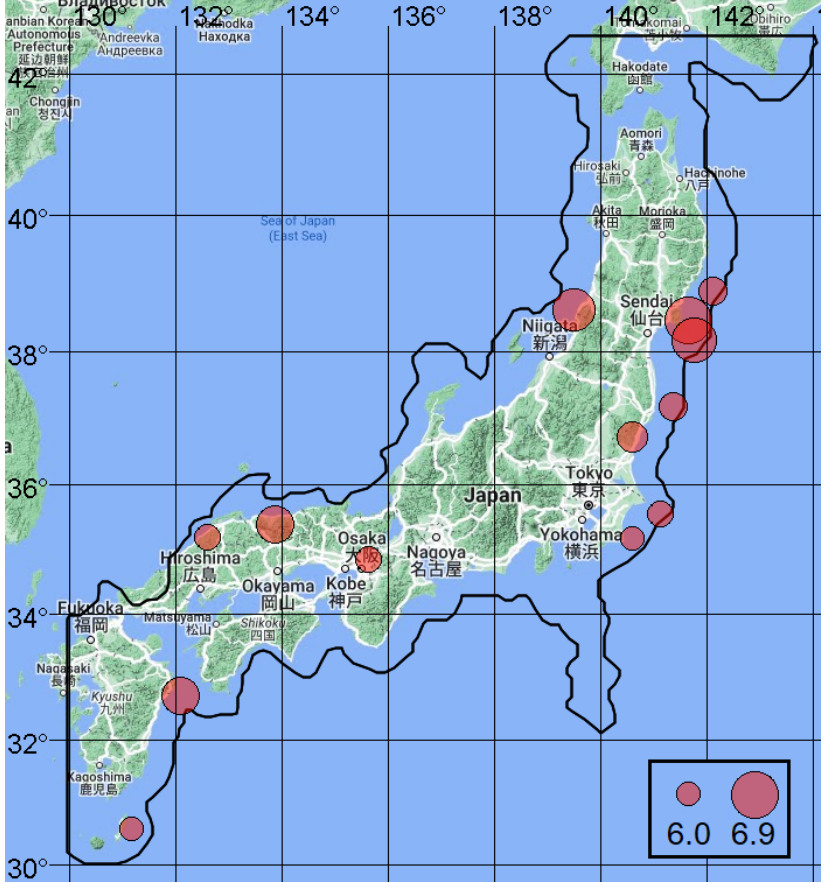
Figure 11. Japan region: analysis zone and epicenters of test earthquakes in the interval 3 August 2016–29 January 2023 with magnitudes with magnitudes m ≥ 6.0 and hypocenter depths H ≤ 60 km. Fields F and S were chosen for the forecast. Field F was calculated according to Formula (8) with parameters T 1 = 630 days, T 2 = 90 days. The field S was calculated using the Gaussian kernel smoothing method. The values of the exponential kernel function are given in (11): r n (km) is the distance from the grid node to the epicenter, t n (days) is the time interval from the grid node to the epicenter, ( t − (cid:101) T ) ≤ t n ≤ t , radius R 0 = 75 km and time interval T 0 = 100 days, and threshold coefficient (cid:101) = 2. The fields are presented in